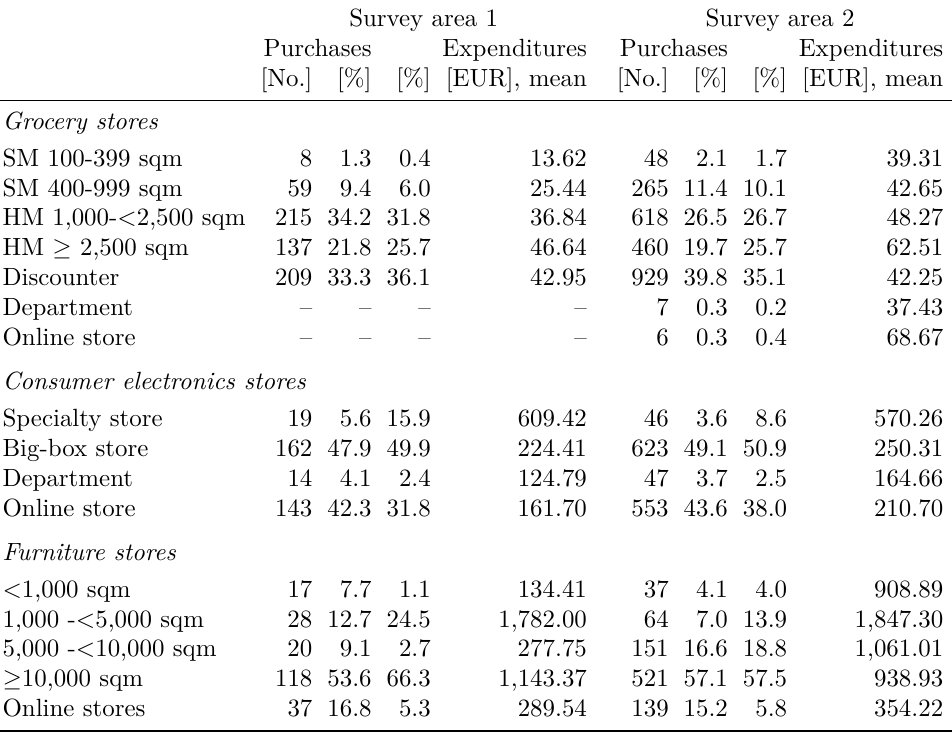
Table 6: Observed purchases (only included) by survey area, retail sector and store